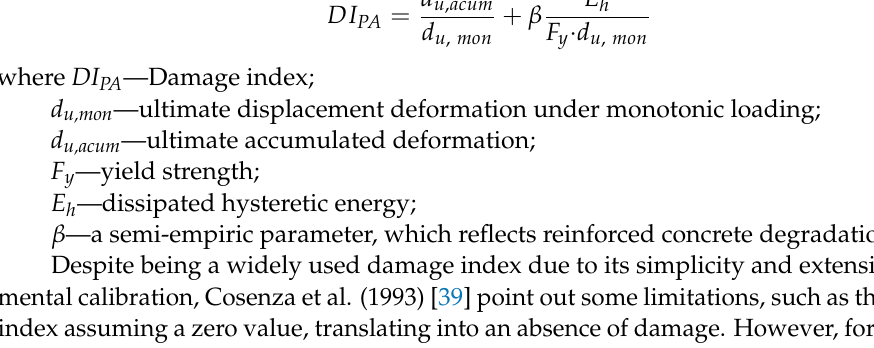
Figure 12. Energy dissipated in an elastoplastic system.